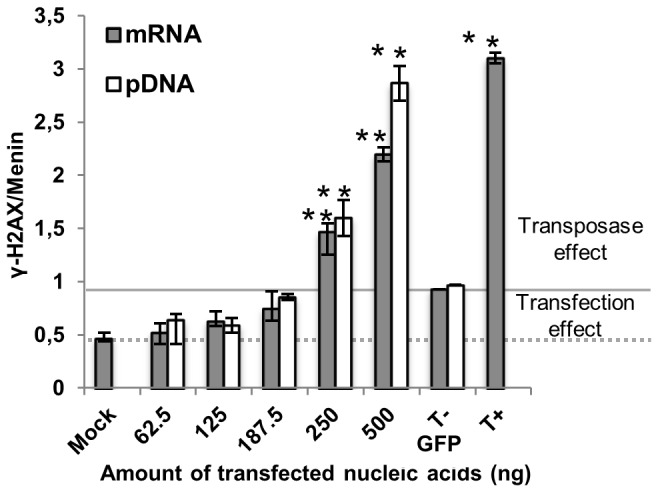
Detection of H2AX phosphorylation following dose-dependent PB mRNA or pDNA transfection.Cells were transfected with indicated amounts of PB mRNA or pDNA and total protein extraction was performed 24 h post-transfection. γ-H2AX expression was determined by Western-Blot and protein quantification was normalized to the endogenous Menin protein. Mock: untransfected cells. T-GFP: cells transfected with 500 ng of GFP mRNA or pDNA. T+: untransfected cells treated with 2 µg/mL doxorubicin (positive control). * Indicates statistically significant differences between treated and untreated cells (p<0.05). Values represent the average of 3 experiments done in triplicate. The signal between the dotted line (mock control) and solid line (T-GFP control) is considered to be due to the “transfection effect”. Above the solid line, the signal is due to the “transposase effect”.